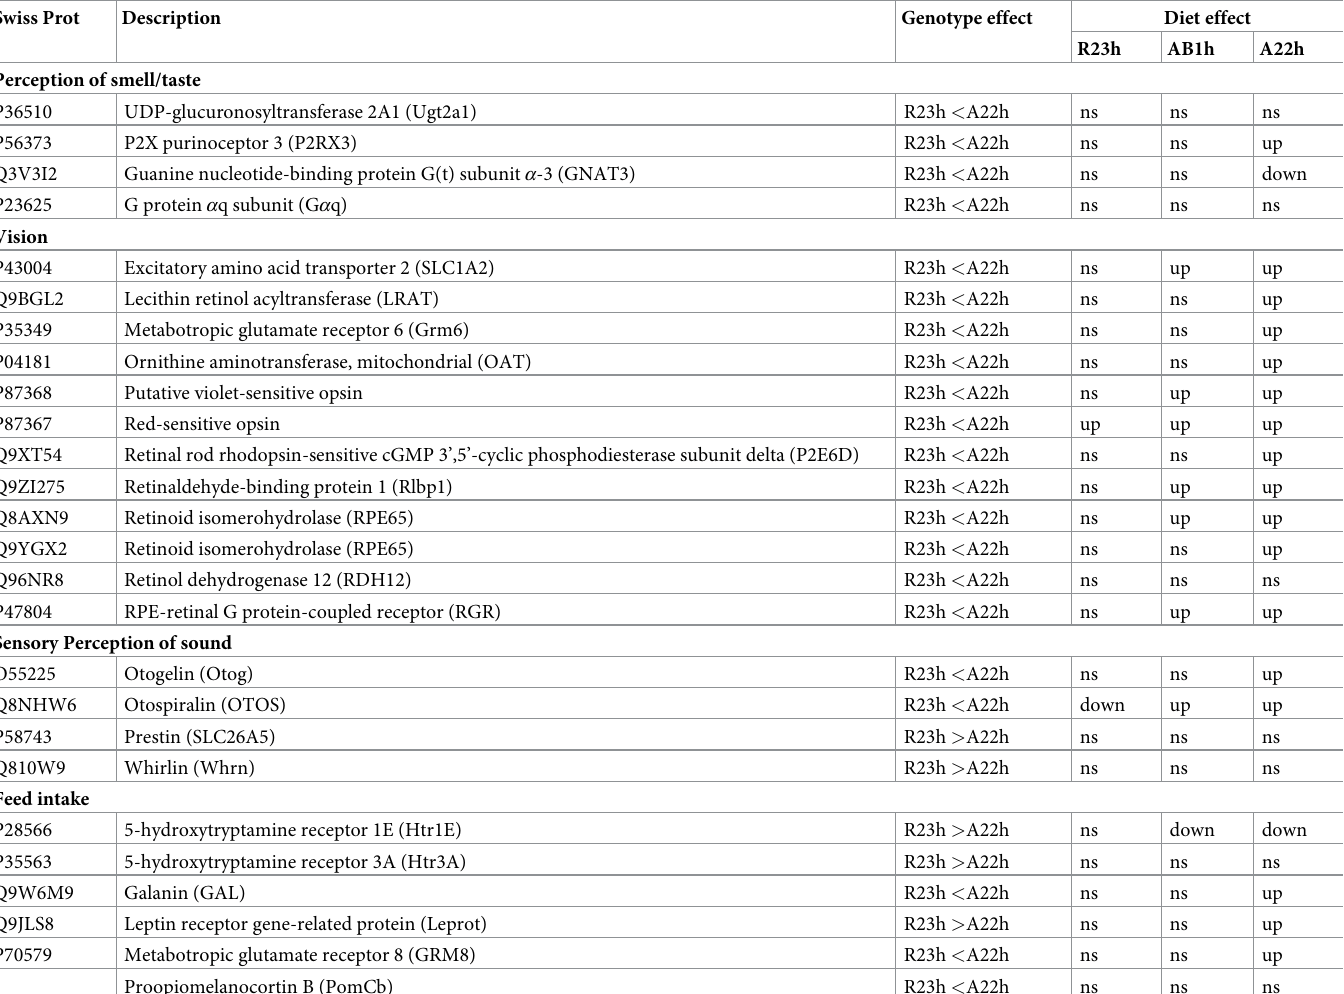
Table 4. Genes differentially expressed between the 3 isogenic lines related to perception. Swiss Prot